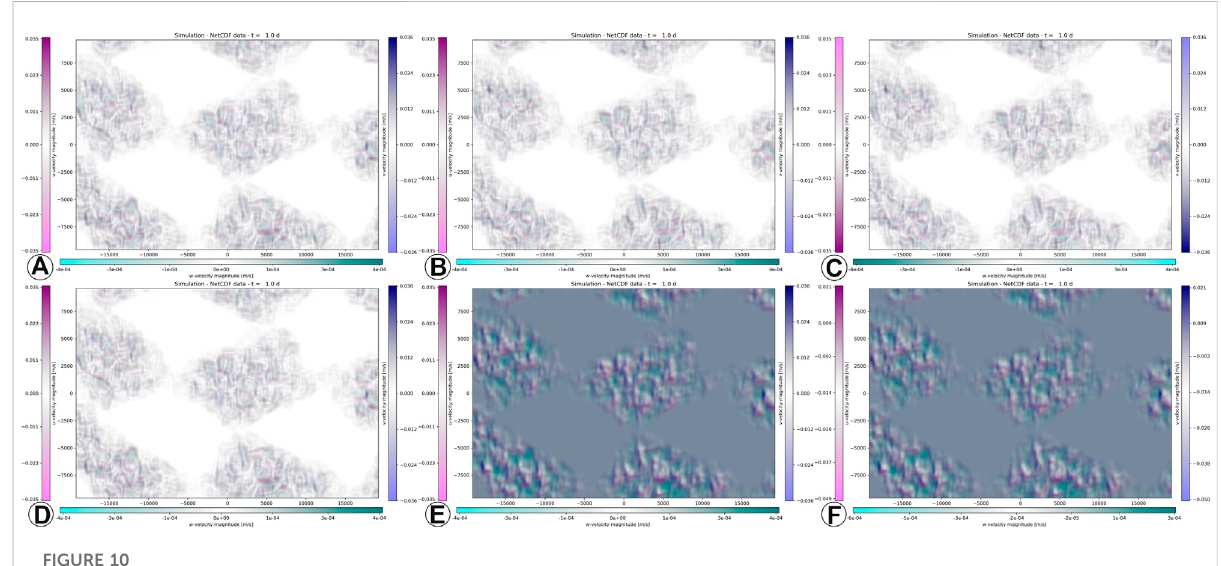
FIGURE 10 Original, unmodulated perceptual mapping, with α = I D and ω = I D , according to Section 4, is shown in (A) and (D) . The inverted data α ′ = D − 1 (B) andtheinvertedvisualmapping ω ′ = ω − 1 (C) areequivalent.The equivalence ofshifted data α ′ = D + κ (E) andshiftedvisualmapping ω ′ = ω + κ (F) also displays a resilience to